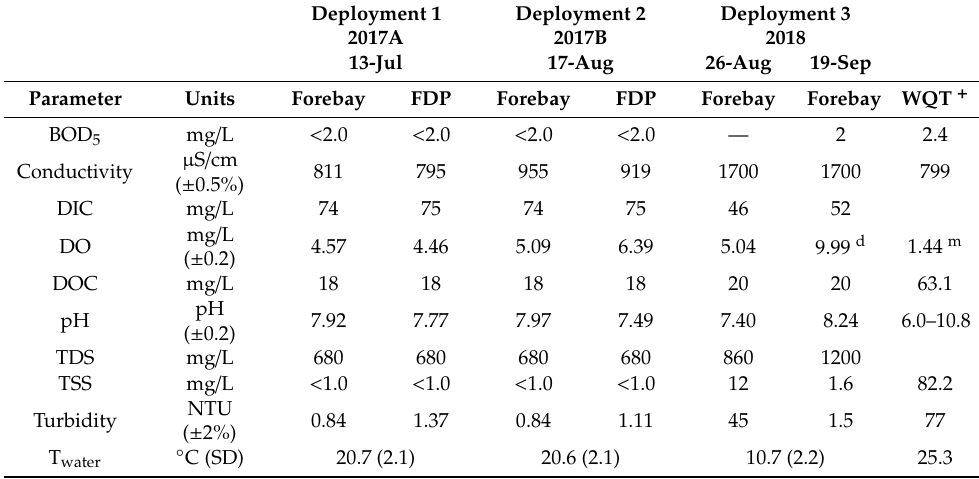
Table 1. Biochemical Oxygen Demand (BOD 5 ), conductivity, Dissolved Inorganic Carbon (DIC), Dissolved Oxygen (DO), Dissolved Organic Carbon (DOC), pH, Total Dissolved Solids (TDS), Total Suspended Solids (TSS), turbidity, and temperature (T water ) of OSPW in the Kearl Treatment Wetland during each deployment